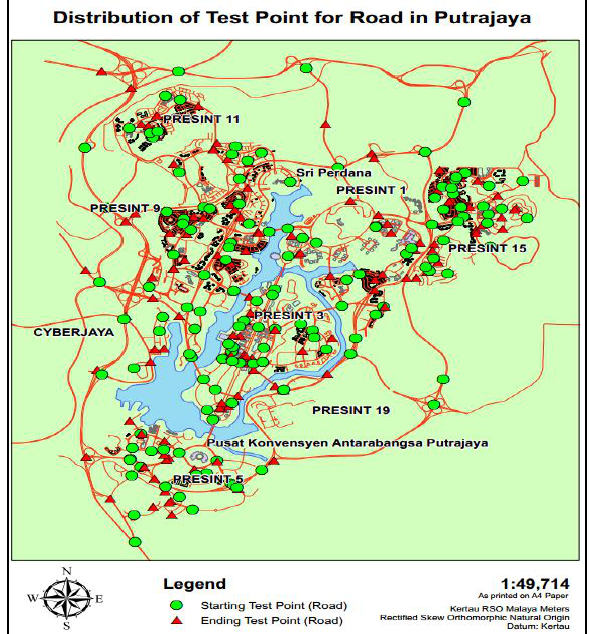
Figure 1: The distribution of sample pair of points for calculating the positional errors of road features